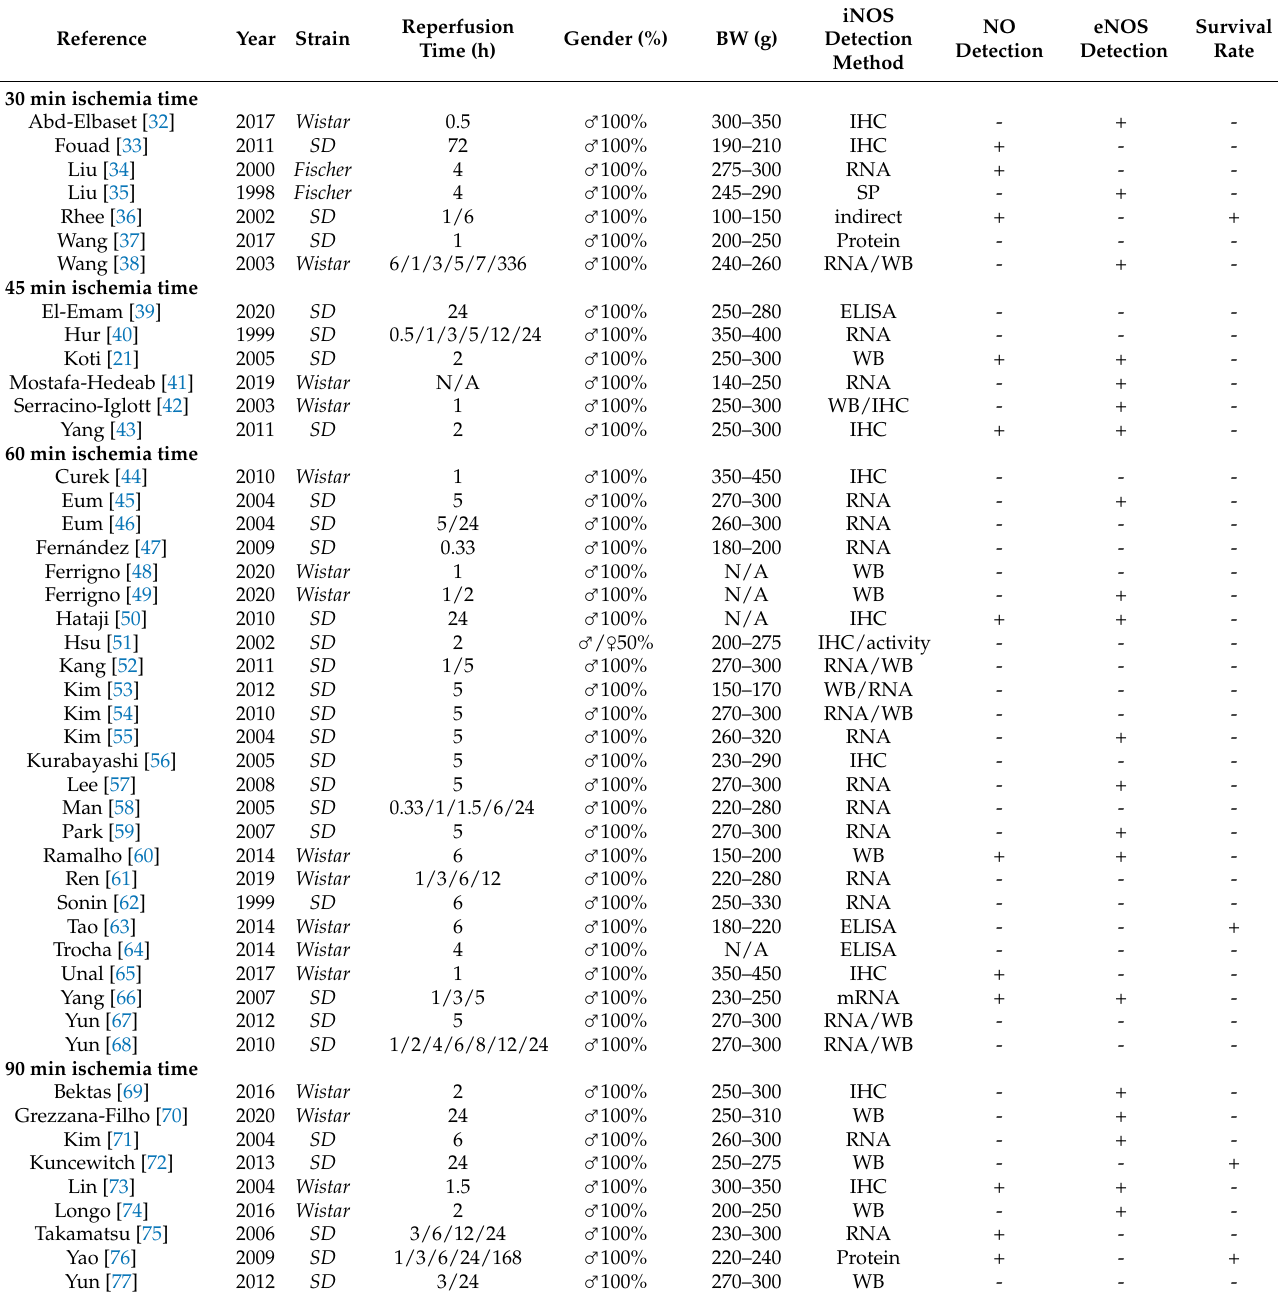
Table 1. Overview of rat models with 70%